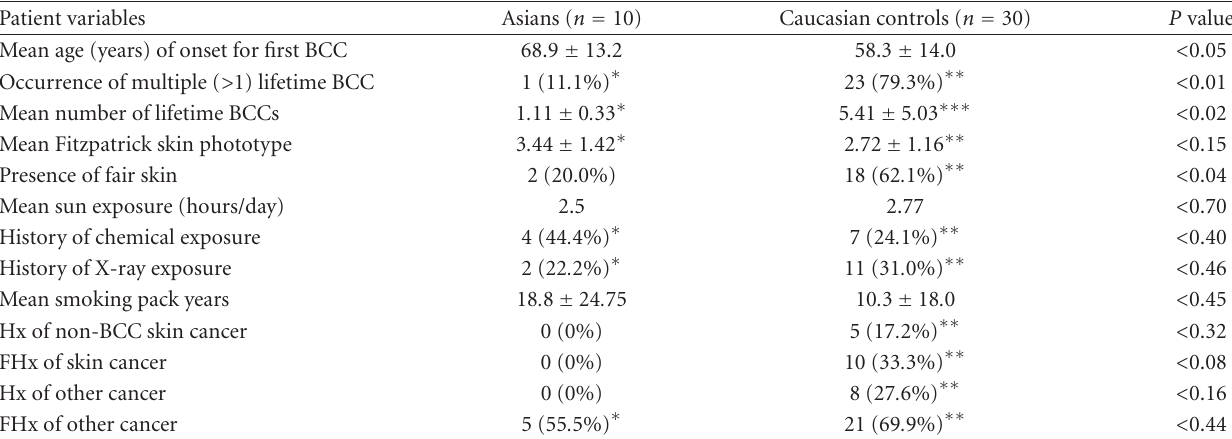
Table 1: Patient